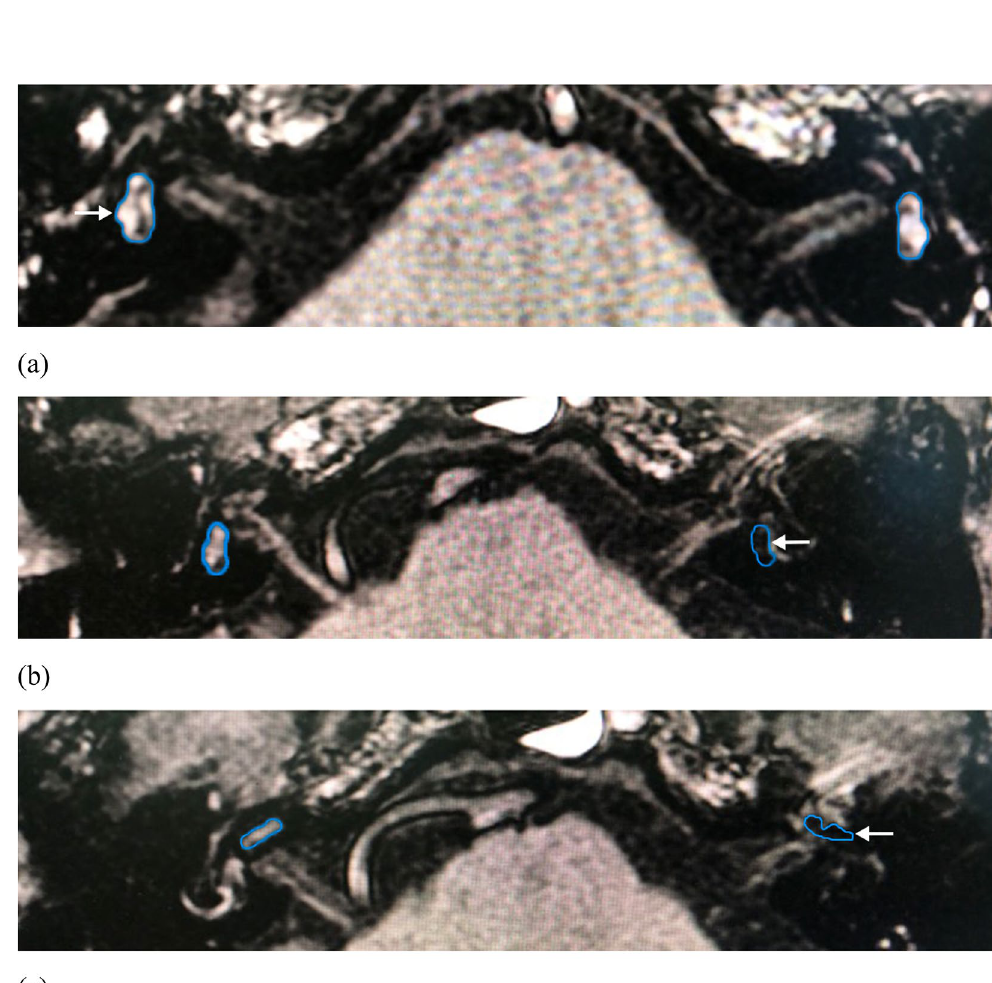
Figure 1. Three-dimensional fluid attenuated inversion recovery (3D-FLAIR) images of patients who diagnosed with definite MD. ( a ) The region of interest (ROI) placement for the mild endolymphatic hydrops (grade 1) in right-sided vestibule (white arrow). ( b ) The ROI placement for the obvious endolymphatic hydrops (grade 2) in left-sided vestibule (white arrow). ( c ) The ROI placement for the significant endolymphatic hydrops (grade 2) in left-sided cochlea (white